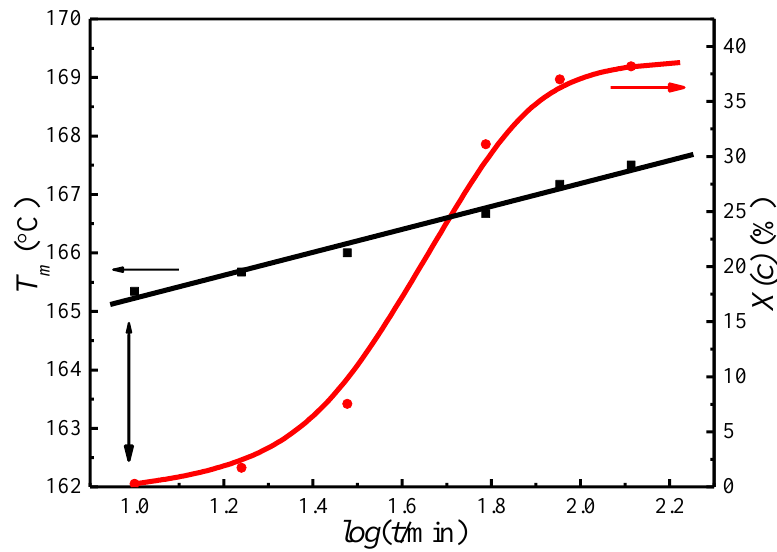
Figure 4. Plots of degree of crystallinity, X (c), and the observed peak melting temperature, T m , as a function of crystallization time at 122 °C.